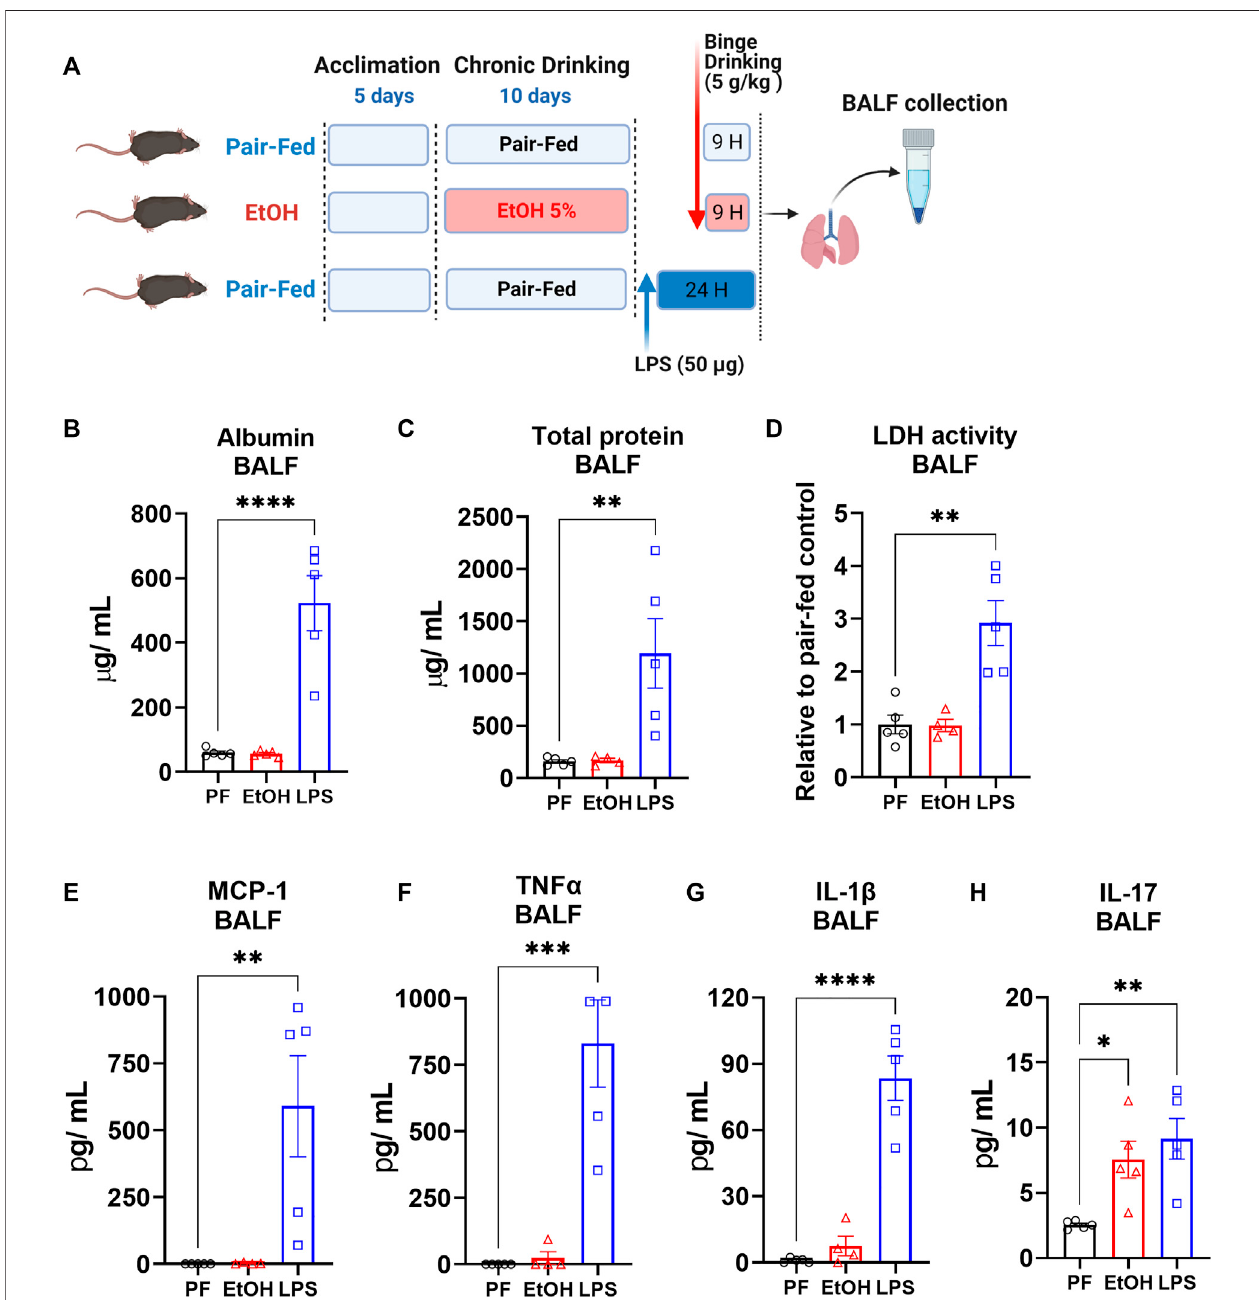
FIGURE 4 | The NIAAA ethanol feeding model did not alter vascular permeability, and epithelial cell membrane integrity but did increase in fl ammatory cytokines in BALF (A) SchematicpresentationofethanolfeedingandoropharyngealLPS(50 ug/mice)inducedlunginjurymodel.Levelsof (B) Albumin, (C) Totalprotein, (D) Lactate dehydrogenase (LDH) activity (E) MCP-1, (F) TNF α , (G) IL-1 β and (H) IL-17 in bronchoalveolar lavage fl uid (BALF) from mice 9 h after either pair-fed or ethanol binge following 10 days chronic feeding or 24 h after oropharyngeal LPS instillation. Data represent mean +S.E.M from 4-5 mice per group. Data were analyzed by one- way ANOVA followed by Dunnett ’ s multiple comparisons test. * ( p < 0.05), ** ( p < 0.01), *** ( p < 0.001), **** ( p < 0.0001) indicates signi fi cant difference from the pair-fed control group.